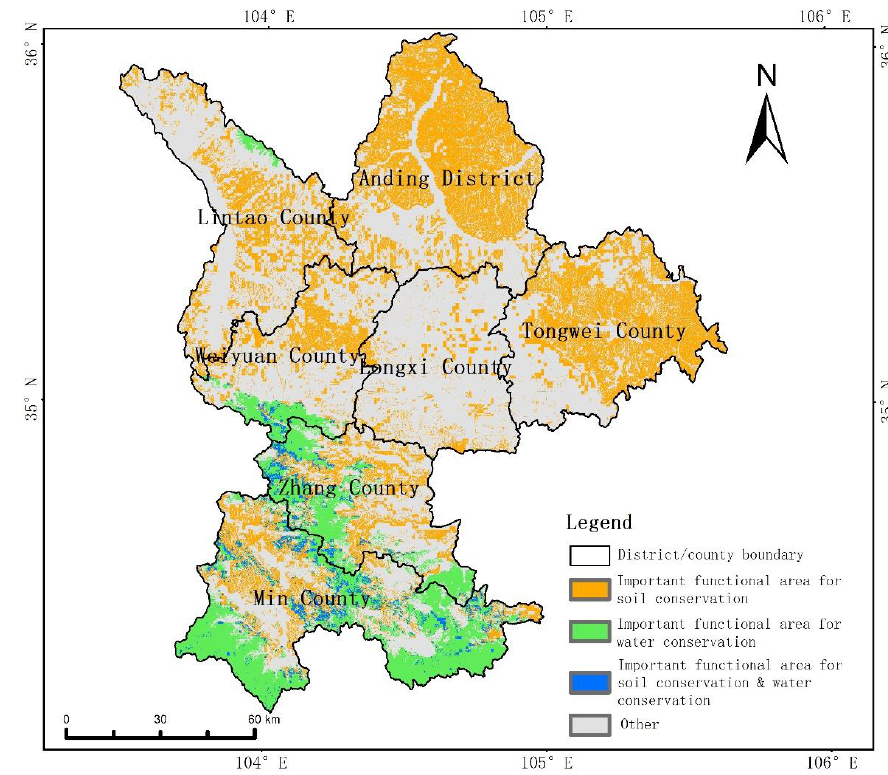
Figure 5. The overlap between important functional areas for soil and water conservation. Table 3. Ratio of soil and water conservation functional areas in the city in different precipitation zones.